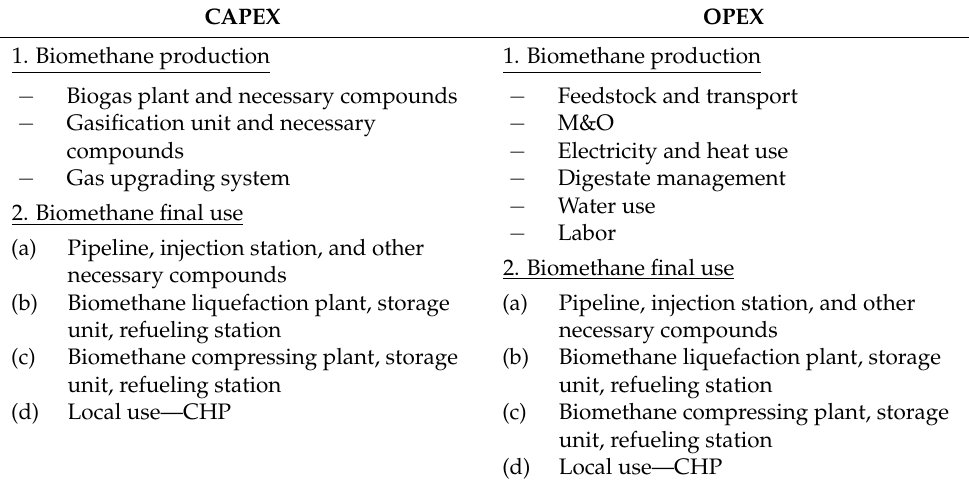
Table 5. CAPEX and OPEX components in the biomethane production